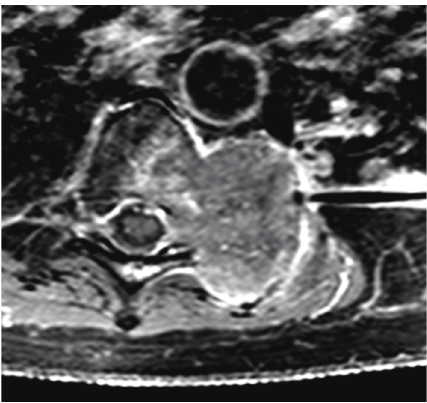
Figure 1: T1 post-Gadolinium fat-saturation MRI T-spine. Note the metastatic tumor in the left paravertebral/chest wall area extending into the epidural space with destruction of the left transverse processes, pedicles, and vertebral bodies. Mass measures 4.0cm in width × 5.8cm cephalocaudally × 4.3 cm anterior- posterior